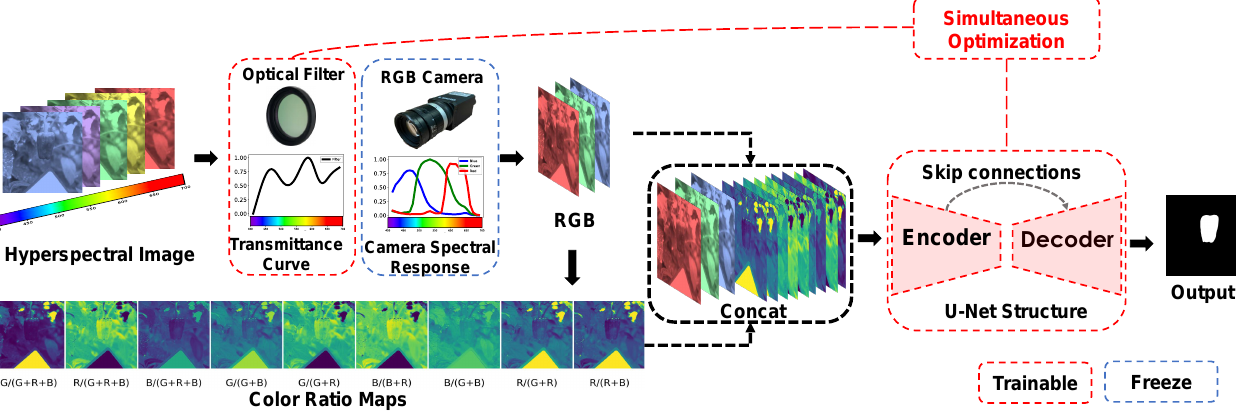
Figure 1. Our proposed computational optics framework incorporates both optics and image segmentation algorithm designs. Rather than optimizing these two parts separately and sequentially, the whole framework was treated as one neural network and establishes a simultaneous end-to-end optimization framework. Explicitly, the first layer of the network corresponds to the physical optical filter, the second layer of the network is related to RGB camera spectral response, and all subsequent layers represent the segmentation algorithm. Inspired by previous research, instead of generating red–green–blue (RGB) channels for the segmentation module, we augment the RGB channels using color-ratio maps to exploit useful spectral information for green pepper segmentation. All of the parameters of the framework are optimized based on segmentation loss on our hyperspectral dataset. Once the transmittance curve is optimized, we can fabricate the corresponding optical filter using multilayer thin-film technology. The fabricated optical filter is mounted in front of the camera lens, and the optimized segmentation network is integrated with the whole